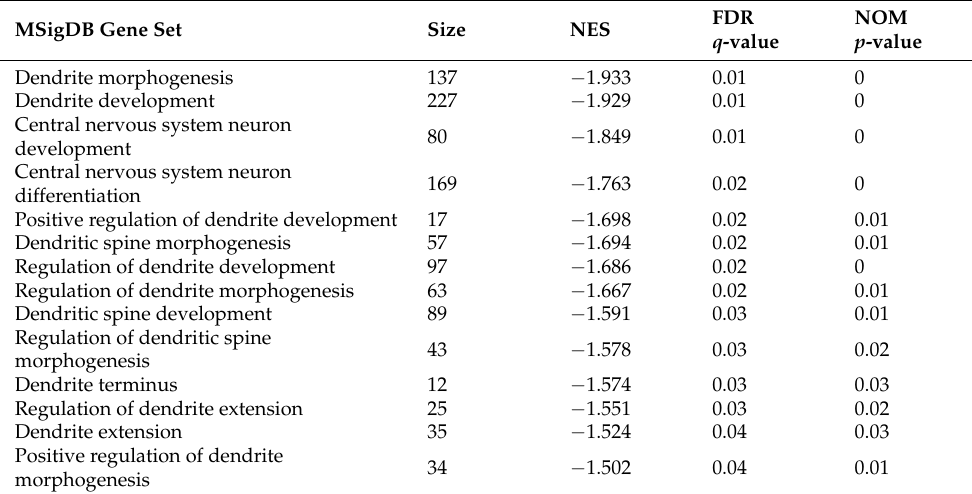
Table 3. Gene Set Enrichment Analysis (GSEA) results according to the MSigDB neuroplasticity- related curated gene